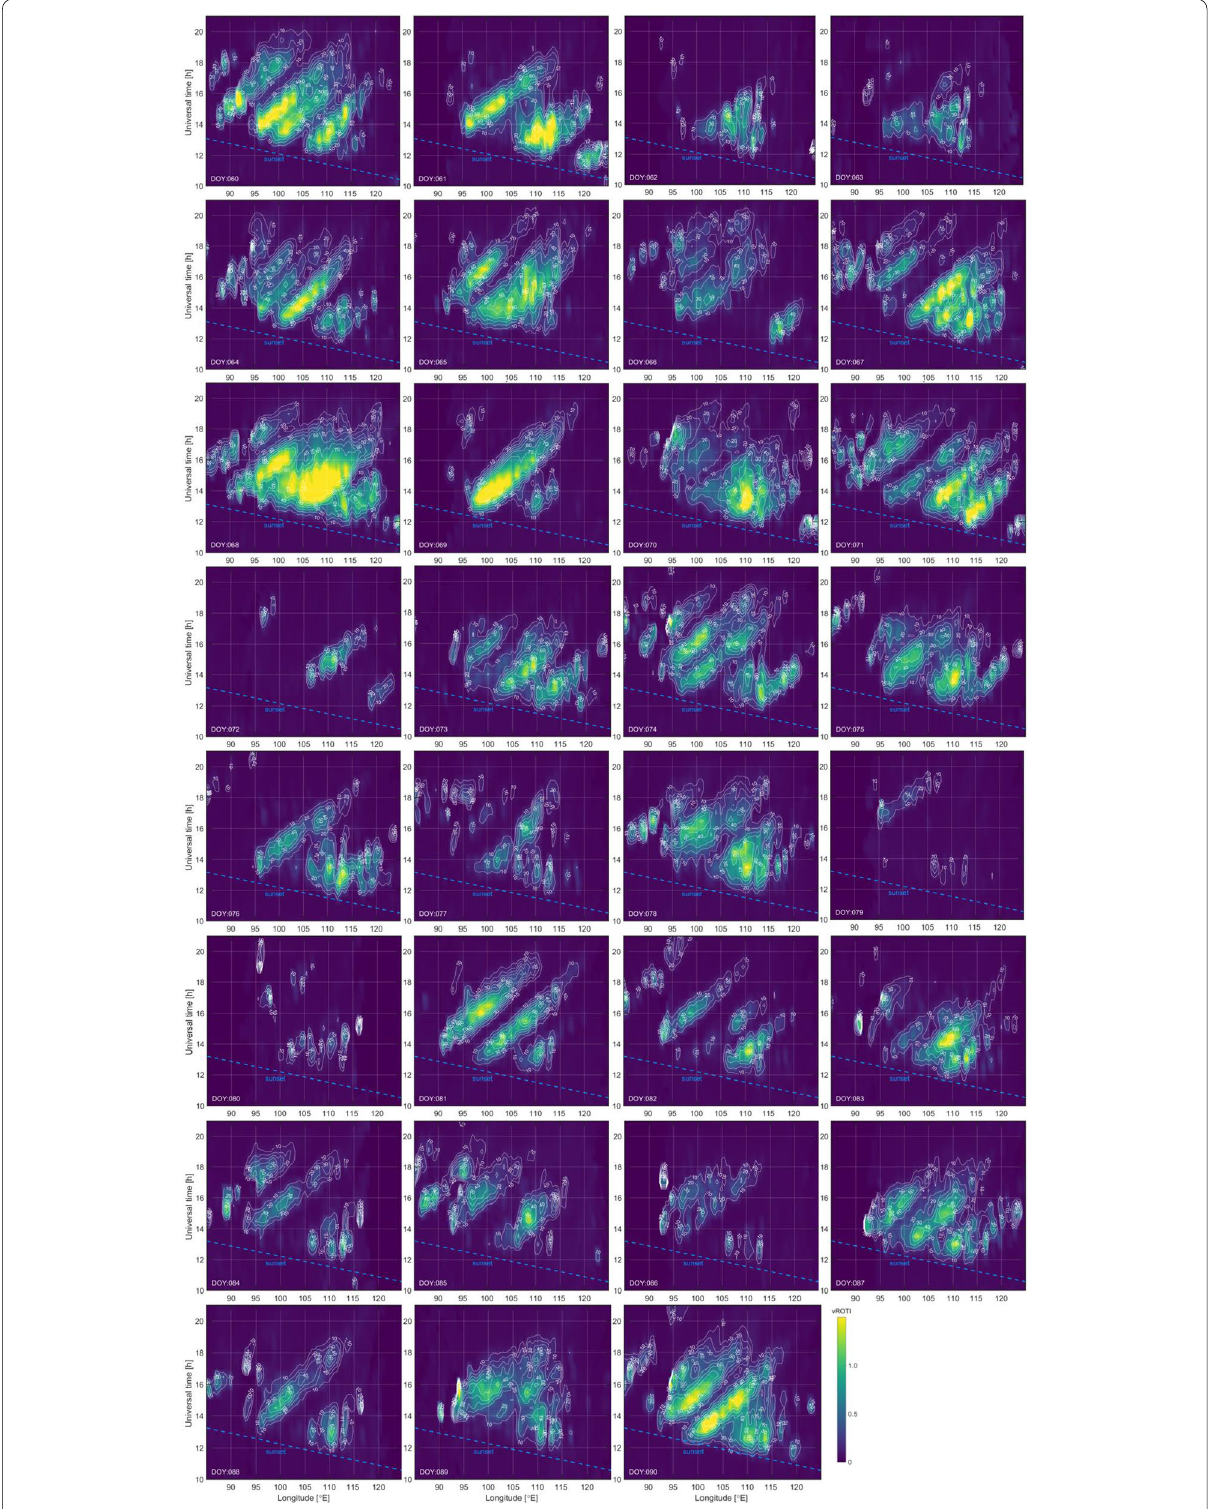
Fig. 4 vROTI keograms based on CMONOC in March